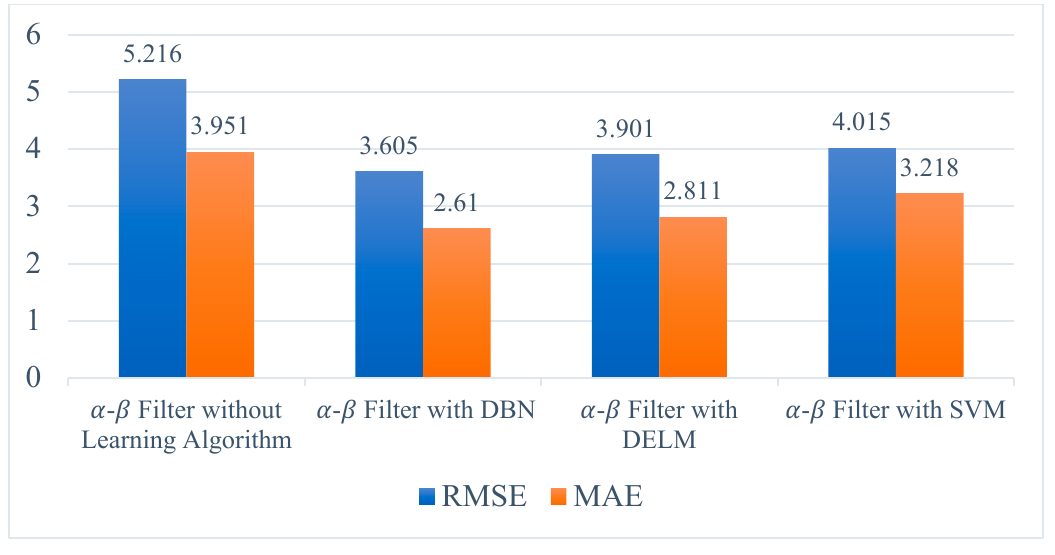
Figure 12. The comparison of typical alpha-beta filter and proposed multi-method in terms of RMSE